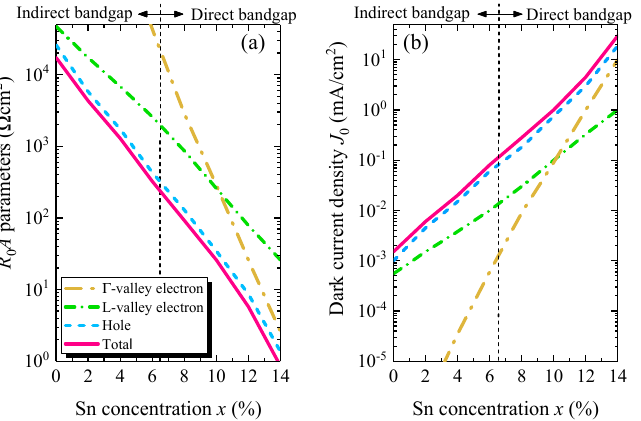
Figure 11. ( a ) Variation of different components and total R 0 A parameters and ( b ) dark current densities of GeSn WGPD with Sn concentration.